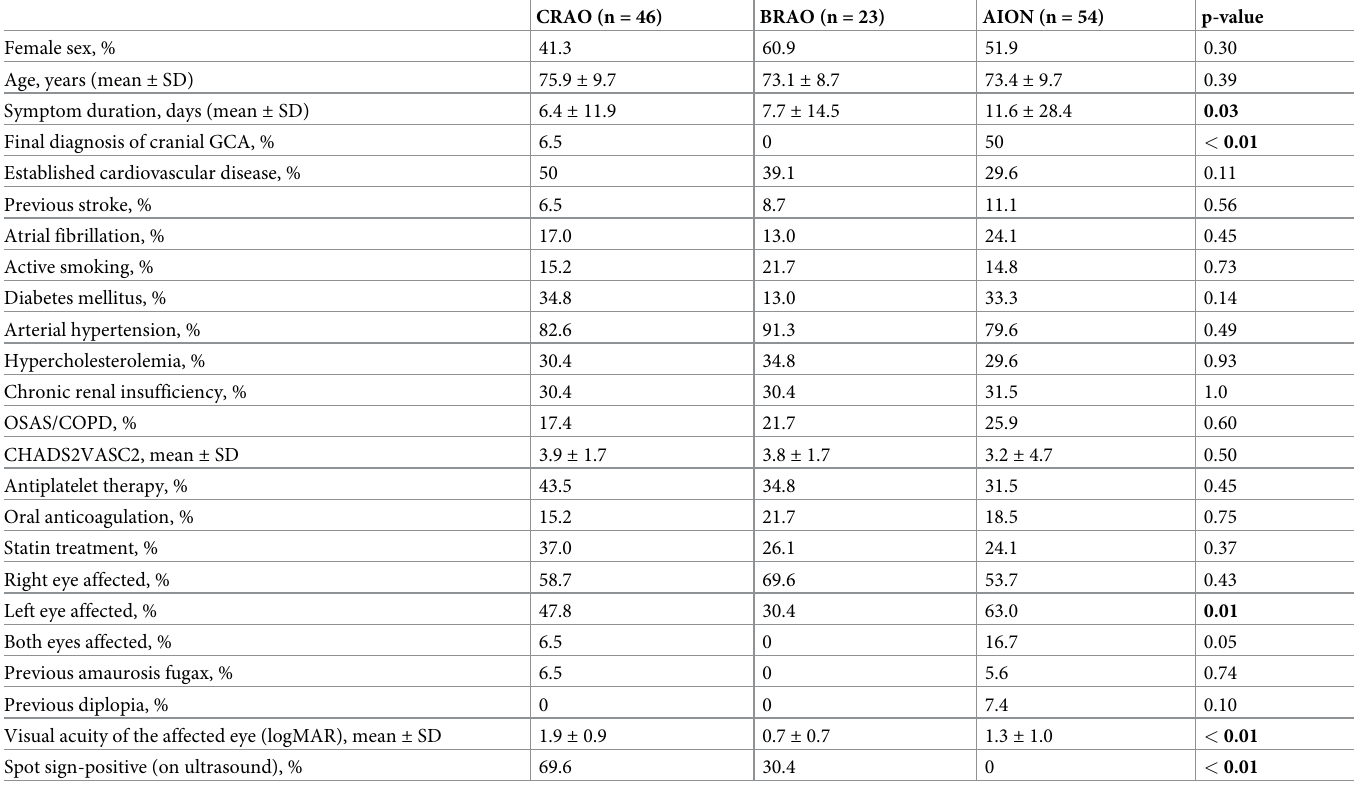
Table 1. Clinical characteristics of patients with CRAO, BRAO, and AION in the overall cohort (n = 123). CRAO (n = 46) BRAO (n = 23) AION (n =